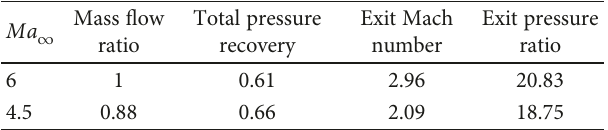
Table 2: Mass-averaged performance of the single-duct inlet under both design and o ff -design conditions.